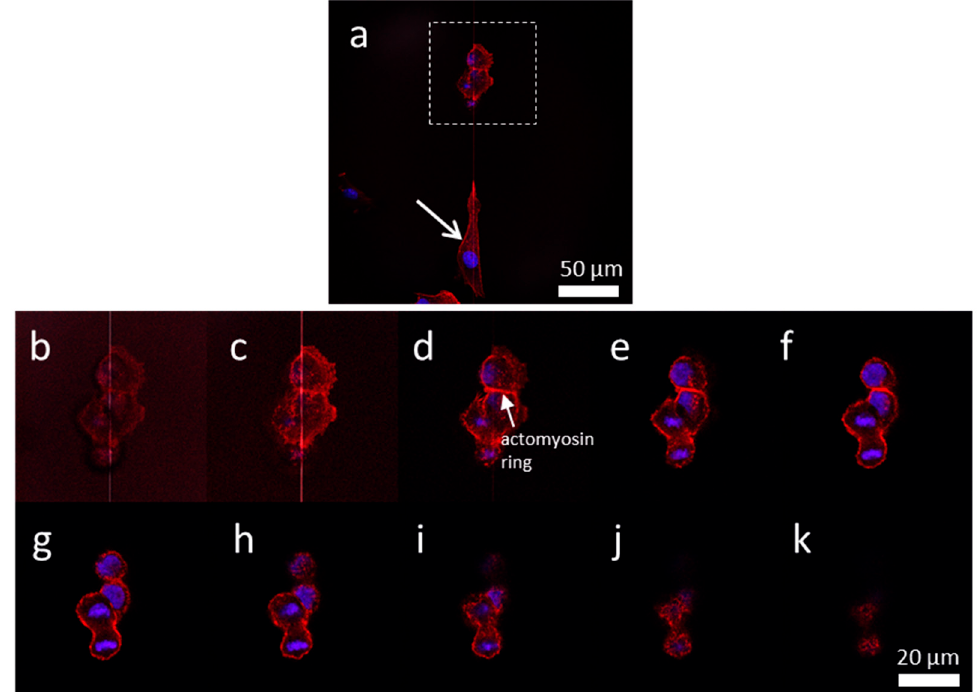
Figure 10. ( a ) Low magnification confocal image of cells adhered to an isolated 1 µm tungsten line. The cell in interphase is labeled with an arrow, while dividing cells are highlighted with a box. Z-stack images ( b ) to ( k ) show the cellular structure near the cell / substrate interface ( b ) and top of the cell ( k